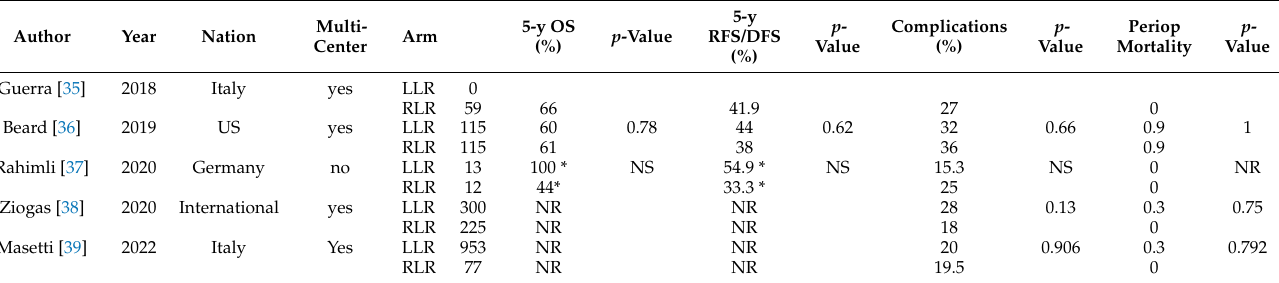
Table 3. Studies comparing robotic and open liver